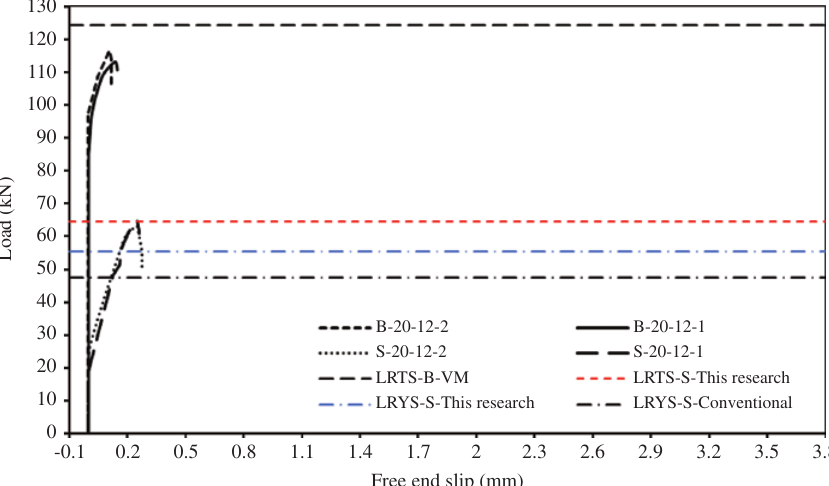
Figure 9: Load and free end slip relationship of 12 mm reinforcement bars and concrete (20 Φ embedment length).